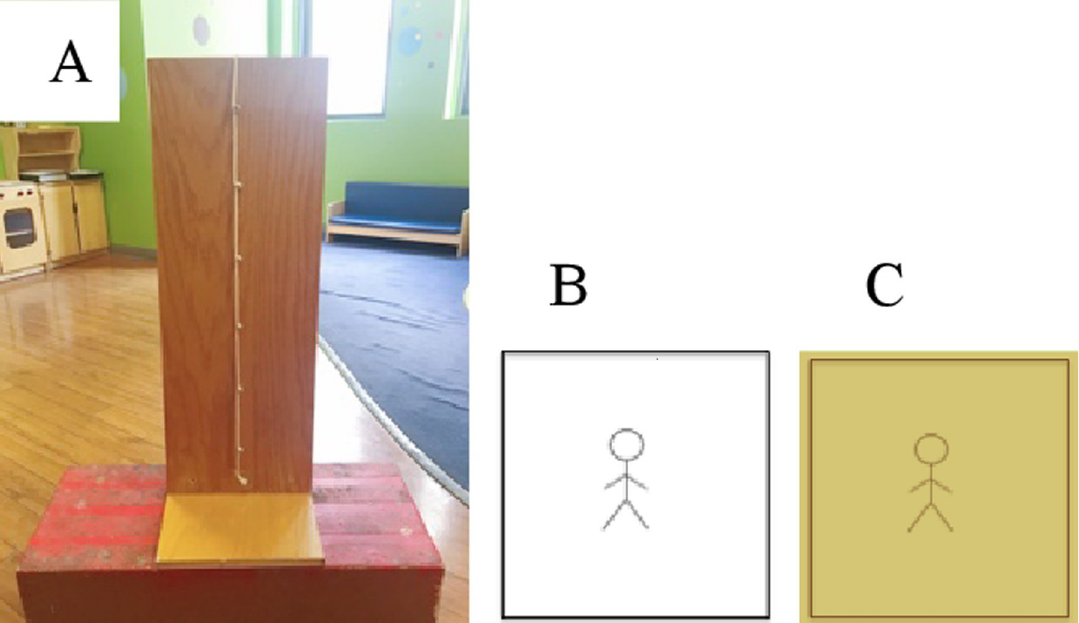
Fig 1. Pictures of (A) board with rope and pegs used for the rope task, including (B) comprehension check stimulus, and (C) example of subjective status card stimulus.